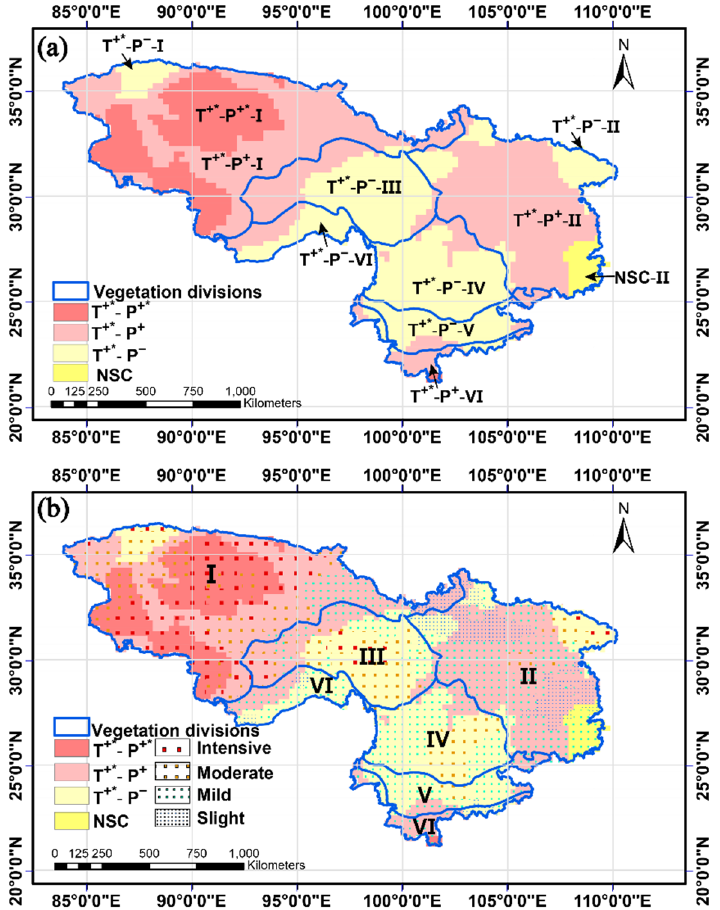
Figure A1 ( a ) The spatial distribution map of sub-regions of climate change and ( b ) the impact degree corresponding to sub-regions of climate change in Southwest China.